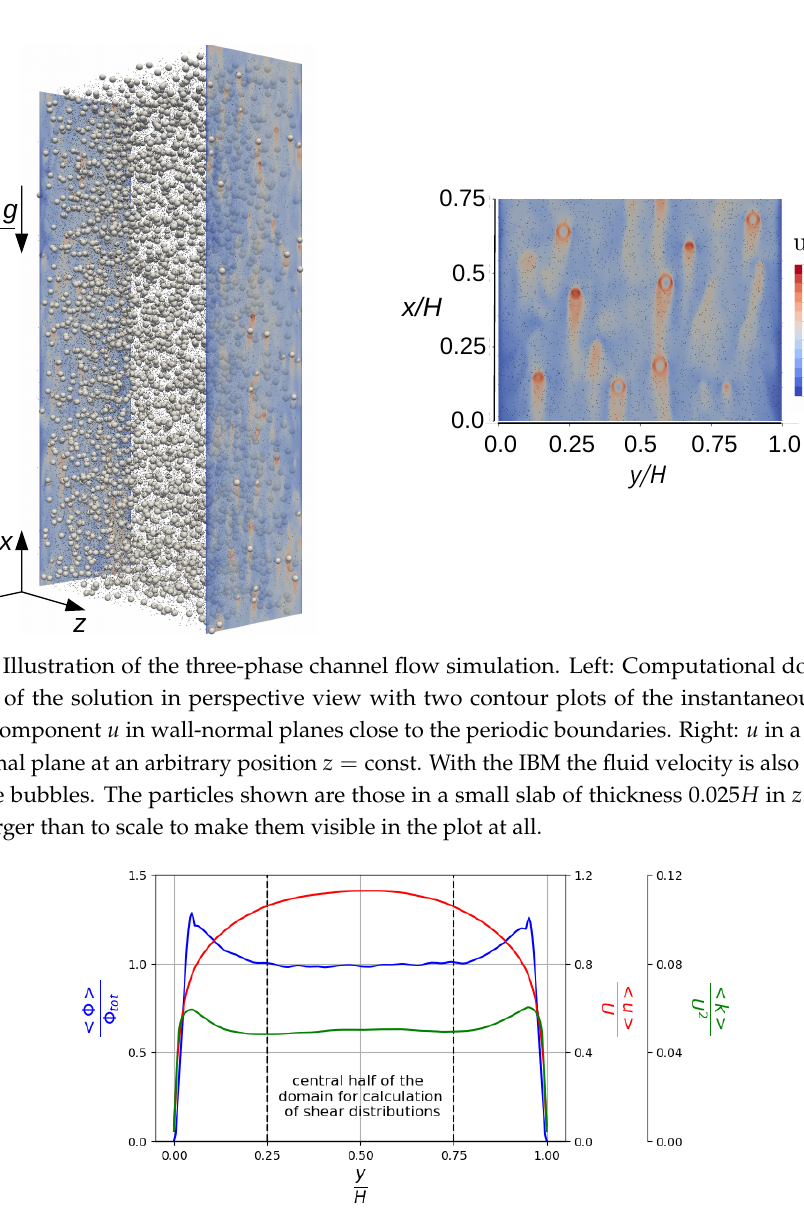
Figure 7. Gas fraction (in blue), mean streamwise velocity (in red) and turbulent kinetic energy (in green) as functions of the wall-normal coordinate in the DNS of the bubbly three-phase flow. After the statistically stationary state of the DNS was reached data were stored for